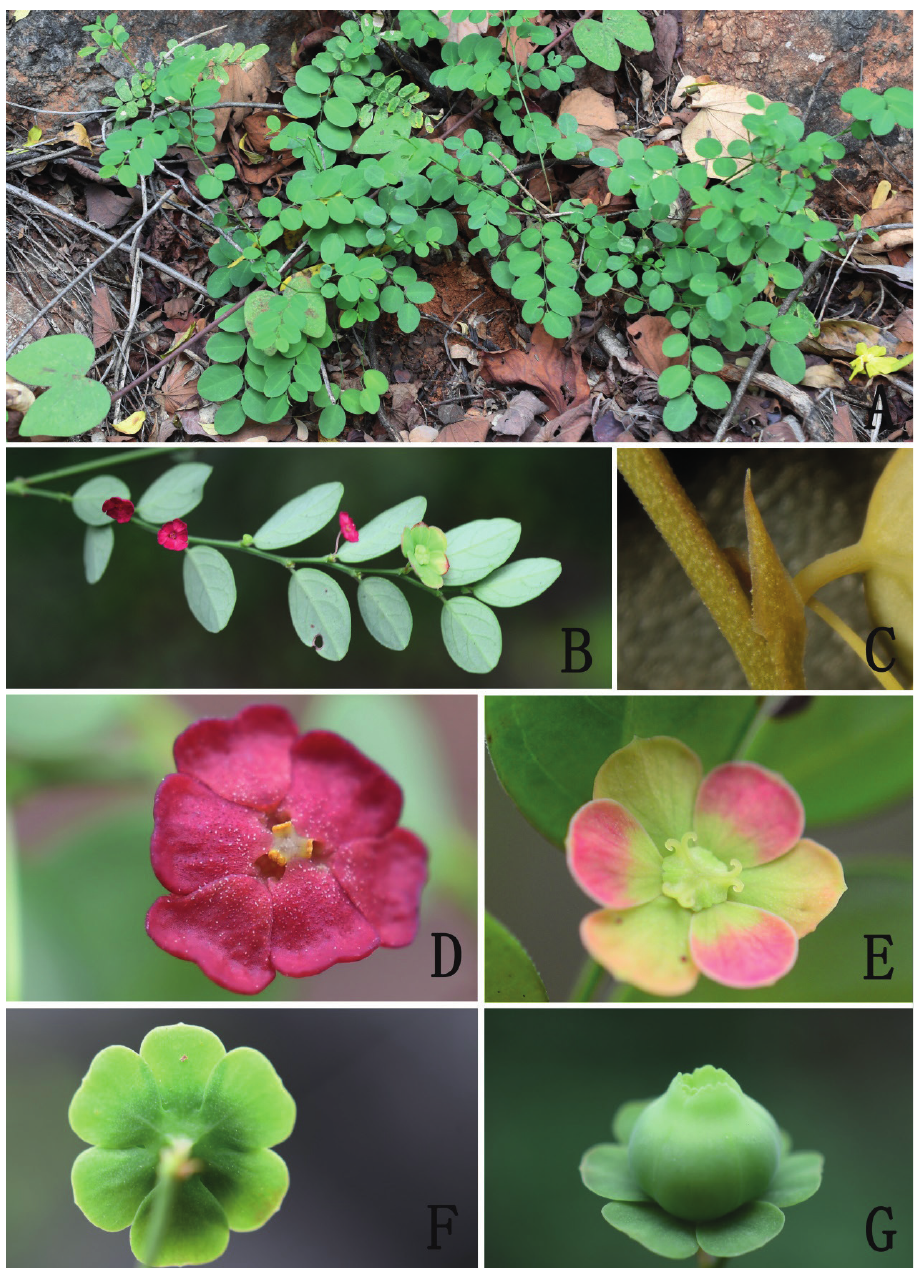
Figure 2. Breynia hiemalis A habit B phyllanthoid branch showing pistillate flower and staminate flowers C stipule D staminate flower (apical view) E pistillate flower (apical view) F calyx in fruit (dorsal view) G fruit. Photographed by H. C. Wang from type locality in January